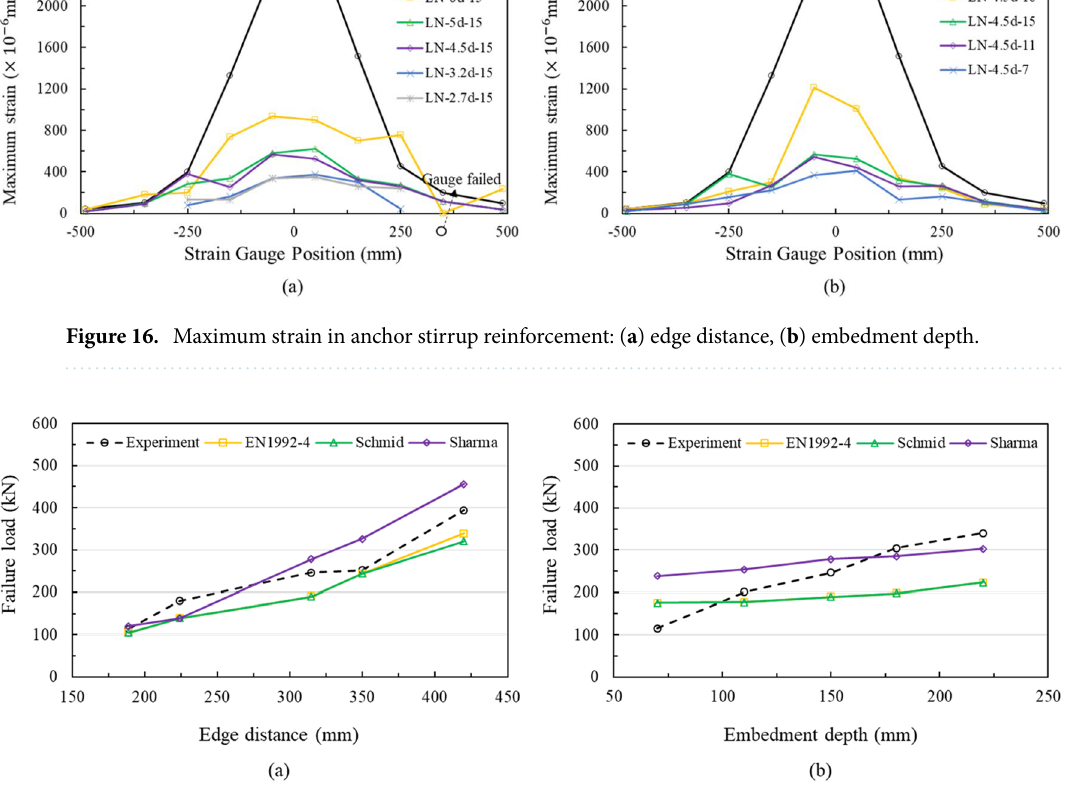
Figure 17. Comparison of failure loads obtained from the tests with calculated failure loads through EN1992- 4 3 , Schmid 59 , and Sharma 62 : ( a ) effect of the edge distance at an embedment depth of 150 mm, ( b ) effect of the embedment depth at an edge distance of